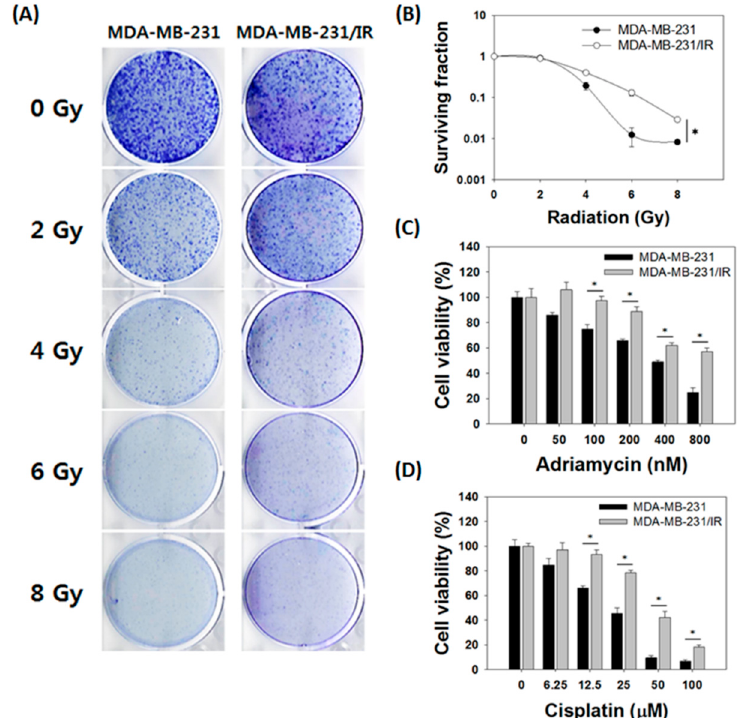
Figure 1. Comparison of parental MDA-MB-231 cells with radio- and chemoresistant MDA-MB-231/IR cells. ( A ) Representative images of the clonogenic assay and ( B ) the surviving fraction of MDA-MB-231 and MDA-MB-231/IR cells after five days of irradiation. MTT assay of MDA-MB-231 and MDA-MB-231/IR cells after ( C ) Adriamycin and ( D ) cisplatin treatment for 24 h. Asterisks (*) indicate significant differences at p < 0.05.